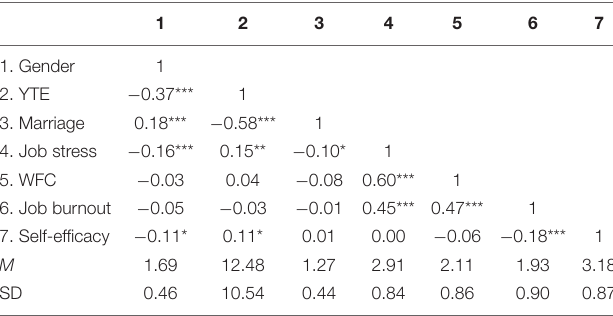
TABLE 1 | Descriptive statistics and correlation among variables ( N = 558).